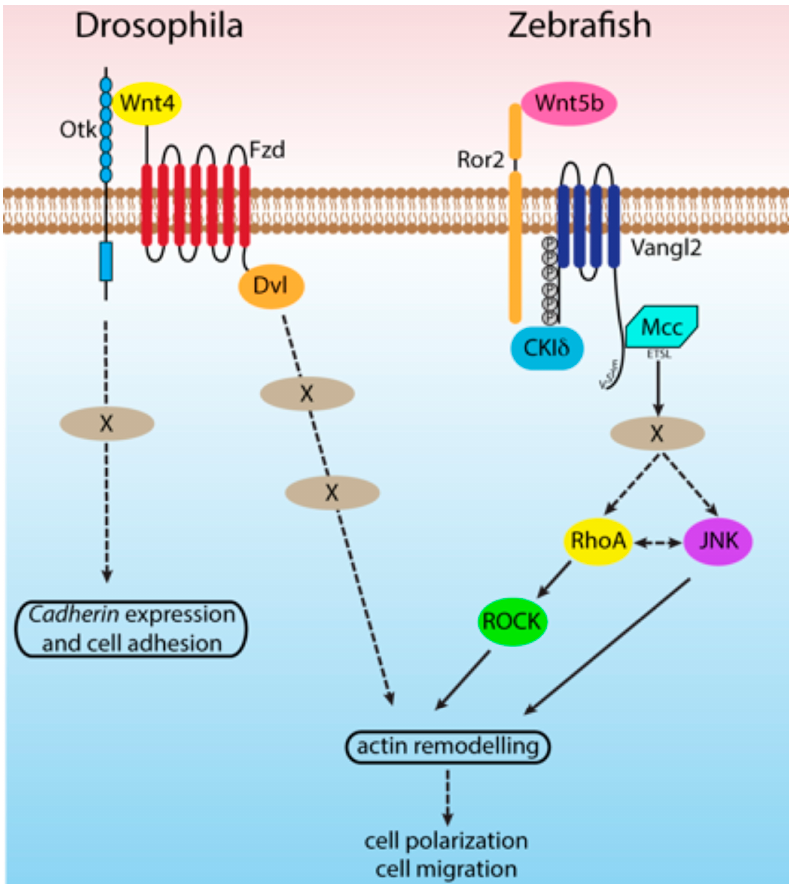
Figure 2. Comparison of the Drosophila and vertebrate non-canonical Wnt pathways applicable to this proposal. The Ptk7/Otk non-canonical Wnt pathway affects several polarity-related signaling molecules, but how direct these effects are is not known. These pathways function through effects on cytoskeleton, adhesion, and subcellular organization.